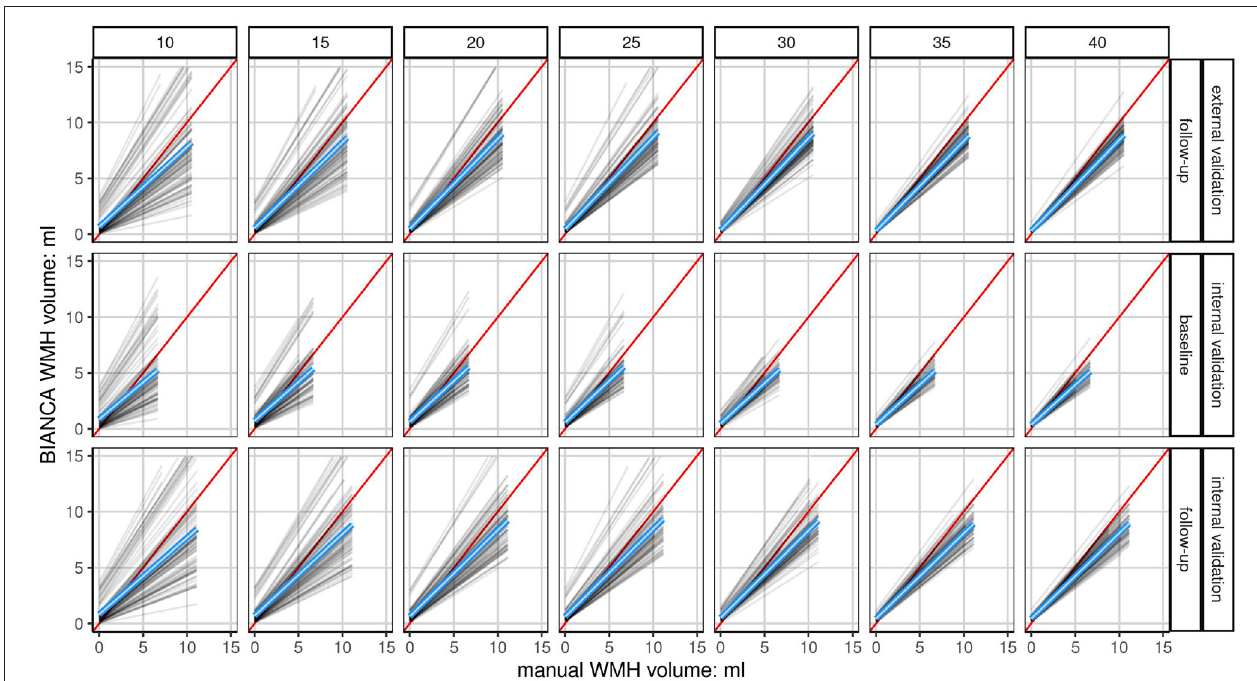
FIGURE 6 | Linear fits of each model show the association of manually segmented total WMH volume to automatically predicted volume (BIANCA) stratified by validation set and sample size. Shown are the linear fits of the manual volume on the x-axis to BIANCA predicted volume on the y-axis of each model ( n = 100) in a grid stratified by sample size ( n = 7) horizontally and validation set ( n = 3) vertically. Only data at a white matter hyperintensity probability threshold of 0.8 is shown. The mean linear fit of all models is indicated by the blue line. The red line indicates the ideal fit, with an intercept of 0 and a slope of 1. The higher the sample size, i.e., the more subjects are drawn from the population, the closer the model performances draw to the mean linear fit of all models. This shows a convergence of the accuracy of each model resulting in a more robust performance. The mean linear fits of all models show an increasing underestimation of white matter hyperintensity volumes by BIANCA with increasing lesion volumes in all sample sizes and sets. Please refer to Supplementary Figure 5 for the same plot showing each participant in a density plot instead of the fit per